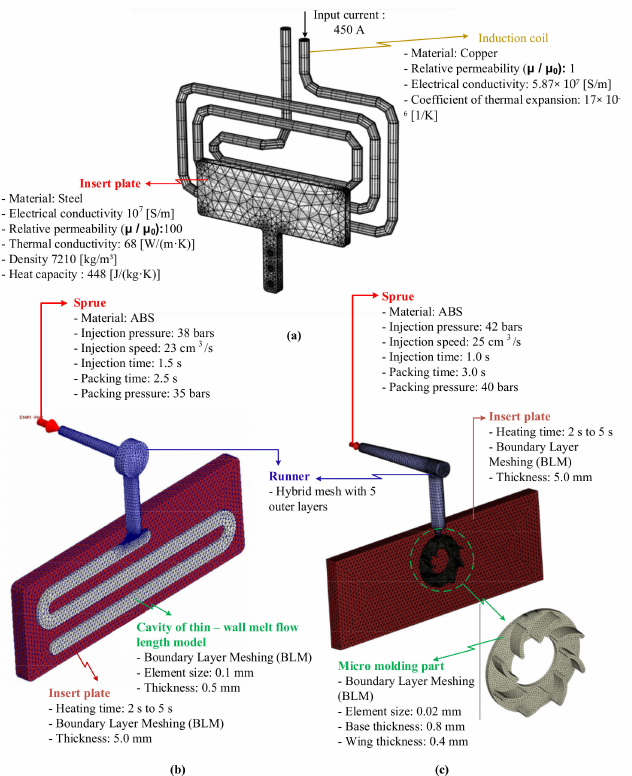
Figure 5. Meshing model for the simulation process in induction heating step ( a ) and molding with the model of melt flow length ( b ) and micro product ( c